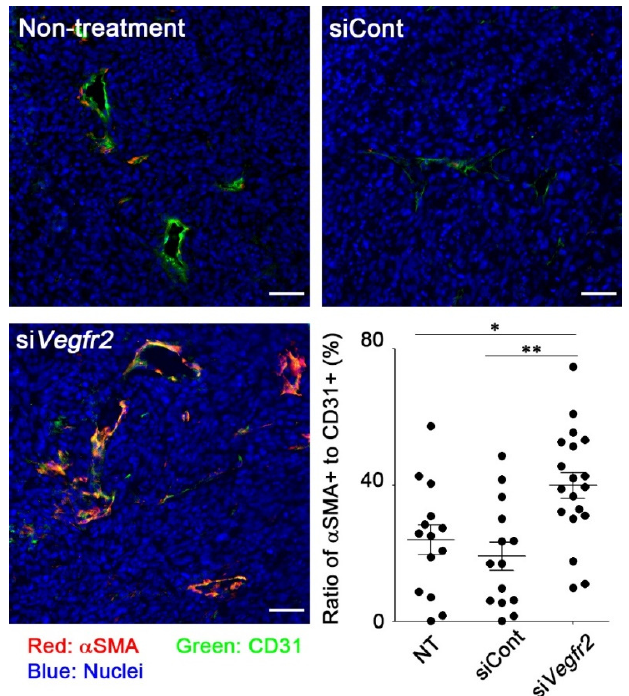
Figure 3. Vascular normalization in MC38 tumors by knockdown of Vegfr2 . MC38 tumor-bearing mice were administered with RGD-LNP encapsulating either si PLK1 as a control, or si Vegfr2 , at a dose of 40 μ g siRNA twice, three days apart. Tumors were harvested 24 h after the final administration, sectioned, and stained as described in the Materials and Methods section. Four tumors from each group were imaged, and CD31-positive cells that were stained with α SAM or not stained were quantified in each image. Red: α SMA (marker of pericytes), green: CD31 (marker of endothelial cells), blue: nuclei. * p < 0.05, ** p <0.01 determined using one-way ANOVA followed by Tukey’s test. Bars: 50 μ m.